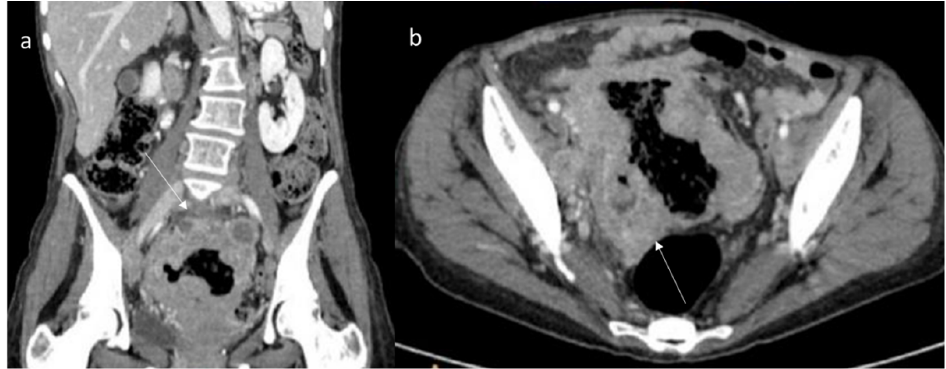
Figure 8. MPR coronal ( a ) and axial CT ( b ) assessment (portal phase of contrast study) of Sigmoid Lymphoma (arrow). The sigma has thickened walls with inhomogeneous contrast enhancement.